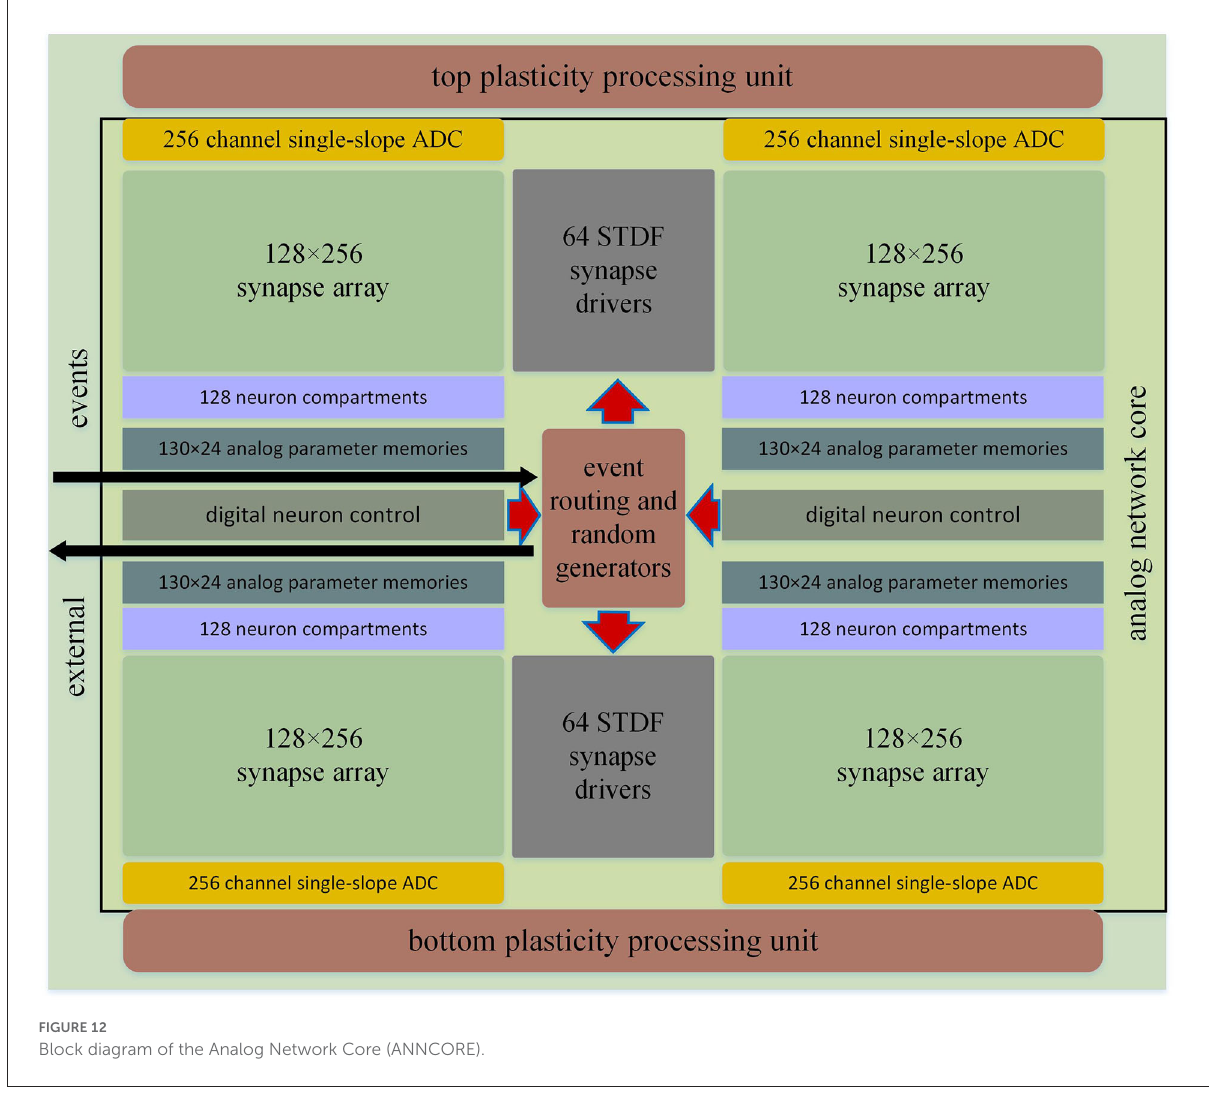
FIGURE12 Block diagram of the Analog Network Core (ANNCORE).